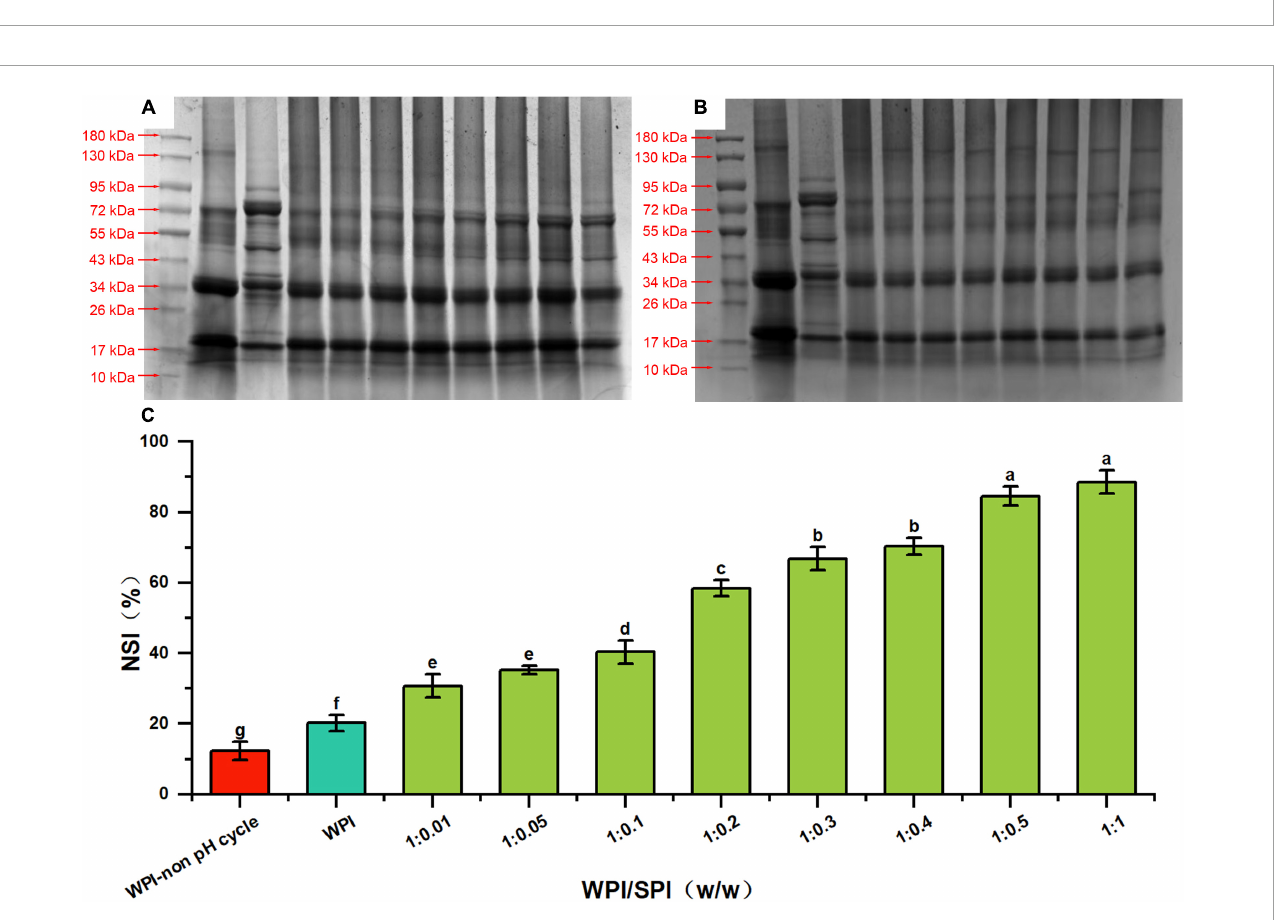
FIGURE2 SDS-PAGE profiles of supernatant (A) and precipitates (B) of prepared composite nanoparticles, respectively (lane 1 is marker, lanes 2–10 are WPI, SPI, composite nanoparticles prepared by WPI: SPI = 1:0.01, 1:0.05, 1:0.1, 1:0.2, 1:0.3, 1:0.4, 1:0.5, and 1:1 (w/w), respectively). (C) Solubility of WPI in composite nanoparticles with WPI: SPI (w/w) from 1:0.01 to 1:1 by the pH-cycle technique (WPI represents walnut protein isolation solution without the pH-cycle treatment, control represents walnut protein isolation solution with the pH-cycle